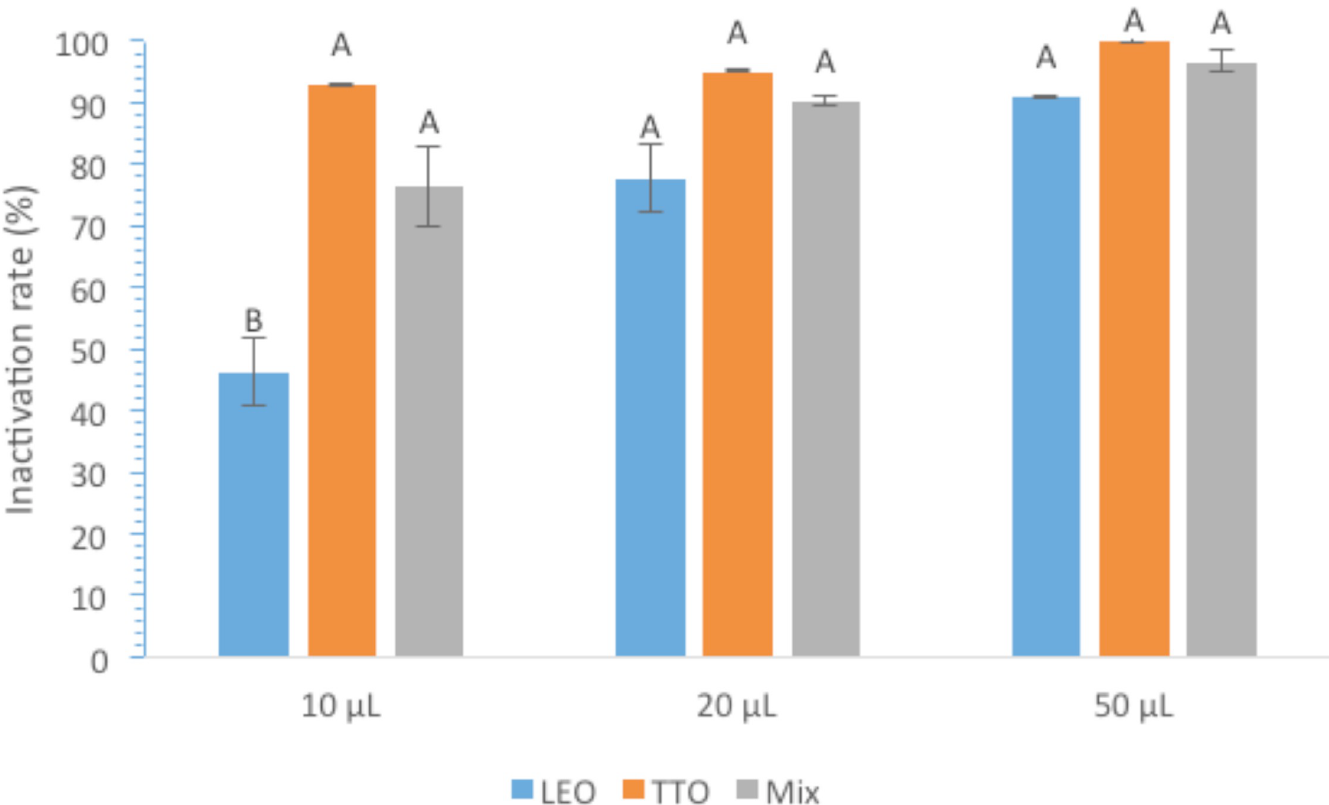
Fig 3. Inactivation rates of E . coli bacteria retained on the surfaces of LEO-MWCNTs, TTO-MWCNTs, or Mix-MWCNTs filters with 10, 20 or 50 μ L EO coatings. Notes: Statistical analysis results are indicated by the letters on the bars. Different letters above the bars indicate statistical difference between the results ( P < 0.05); Identical letters above the bars indicate no statistical